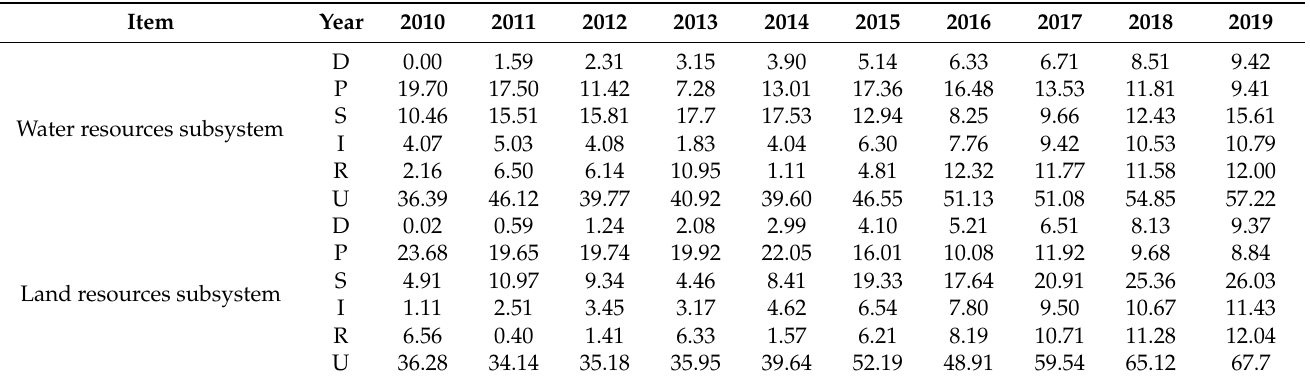
Table 5. Evaluation results of the development level of the WALR subsystems. Unit: 10 − 2